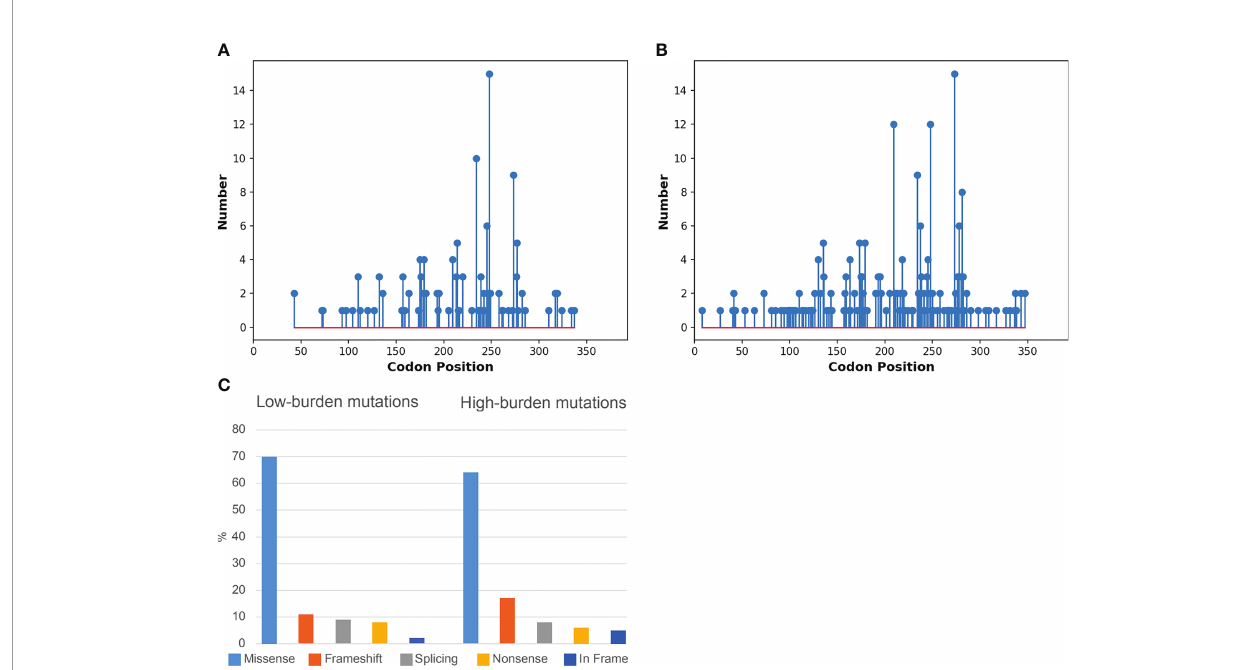
FIGURE 3 | Molecular Pro fi le of TP53 mutations in low and high burden cohorts. (A) Needle plot graph of low burden TP53 mutations along the TP53 coding sequence. (B) Needle plot graph of high burden TP53 mutations along the TP53 coding sequence. (C) Bar chart of mutations effect on the p53 protein in terms of amino acid changes in the low and high burden